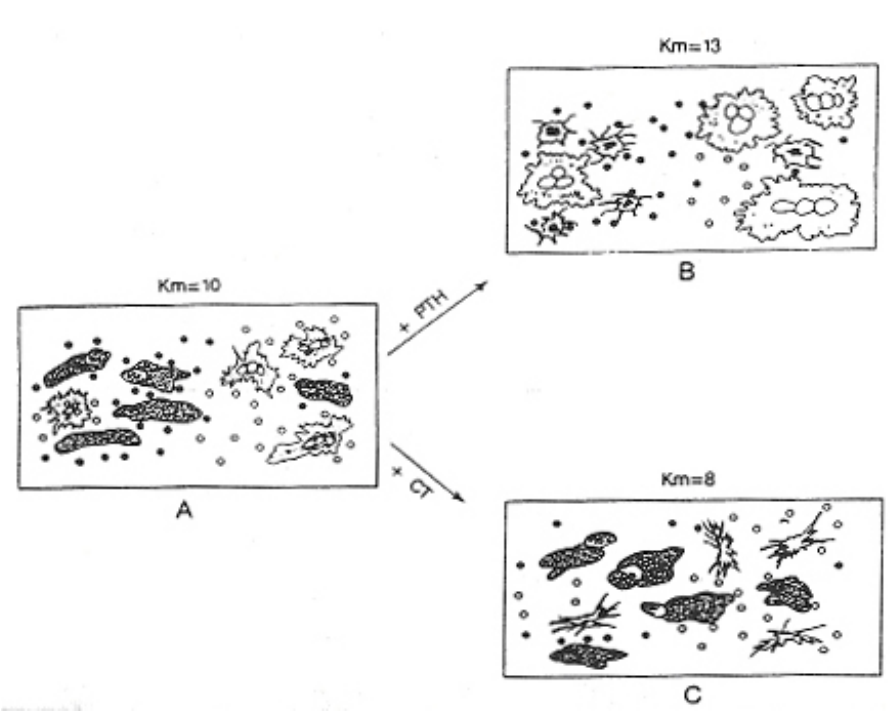
FIGURE 1. Diagram representing the effect of the acute administration of parathyroid hormone (PTH) or calcitonin (CT) on the spatial relationships of osteoblasts and osteoclasts on a bone surface. The open and closed circles represent, respectively, the K m values of the high-affinity bone calcium-binding sites. (A) Represents a normocalcemic situation, with an equal number of high- and low-affinity sites. (B) Represents the result of PTH administration, where the shrinkage of osteoblasts has exposed low-affinity sites and the associated expansion of osteoclasts has blocked high-affinity sites, leading to an average K m of 13 and hypercalcemia. (C) Represents the result of CT administration, where the shrinkage of osteoclasts has exposed high-affinity sites and the consequent expansion of osteoblasts has blocked low-affinity sites, leading to an average of K m of 8 and hypocalcemia. Note: High-affinity sites are considered to have an apparent K m of 5 mg Ca/dl, with low-affinity sites an apparent K m of 15 mg Ca/dl. For the sake of convenience, the K m ’s refer to total plasma calcium, rather than the theoretically correct ionic calcium concentration, approximately half of the total. Bone mineral with a high Ca:P ratio is considered to have a relatively higher affinity for calcium binding than bone mineral with a low Ca:P ratio (see text and Table 1). Reproduced with permission of Bronner and